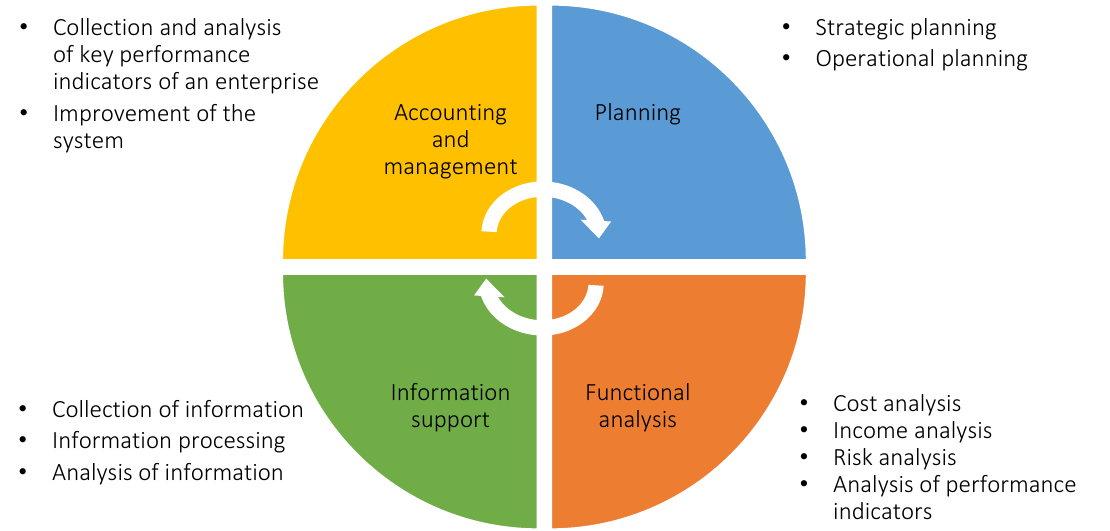
Figure 1. Major control